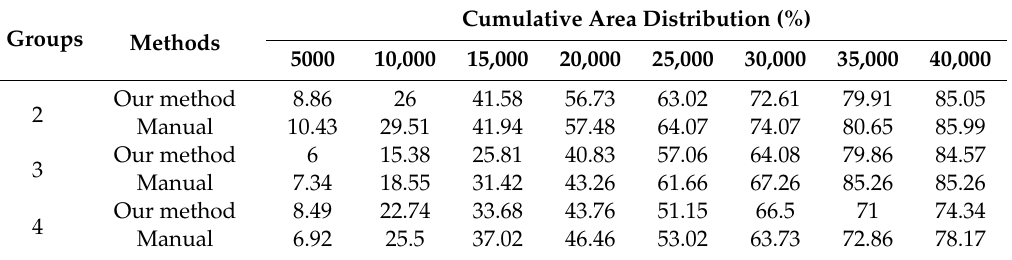
Table 4. The results of coarse material images from groups 2 to 4, processed by our method.